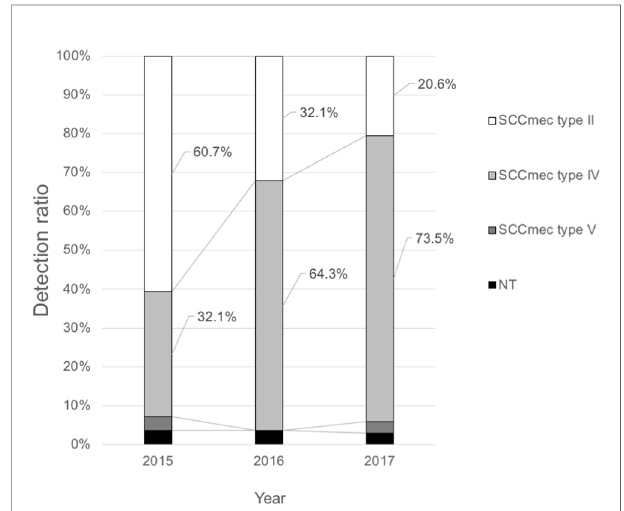
FIGURE 1 | Trends of the SCC mec types of methicillin-resistant Staphylococcus aureus from blood culture samples at the Toho University Omori Medical